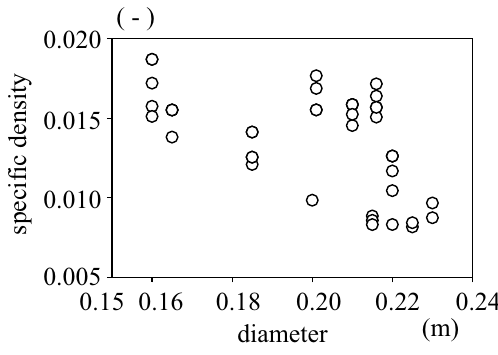
Figure 2. Diameter and underwater specific density of